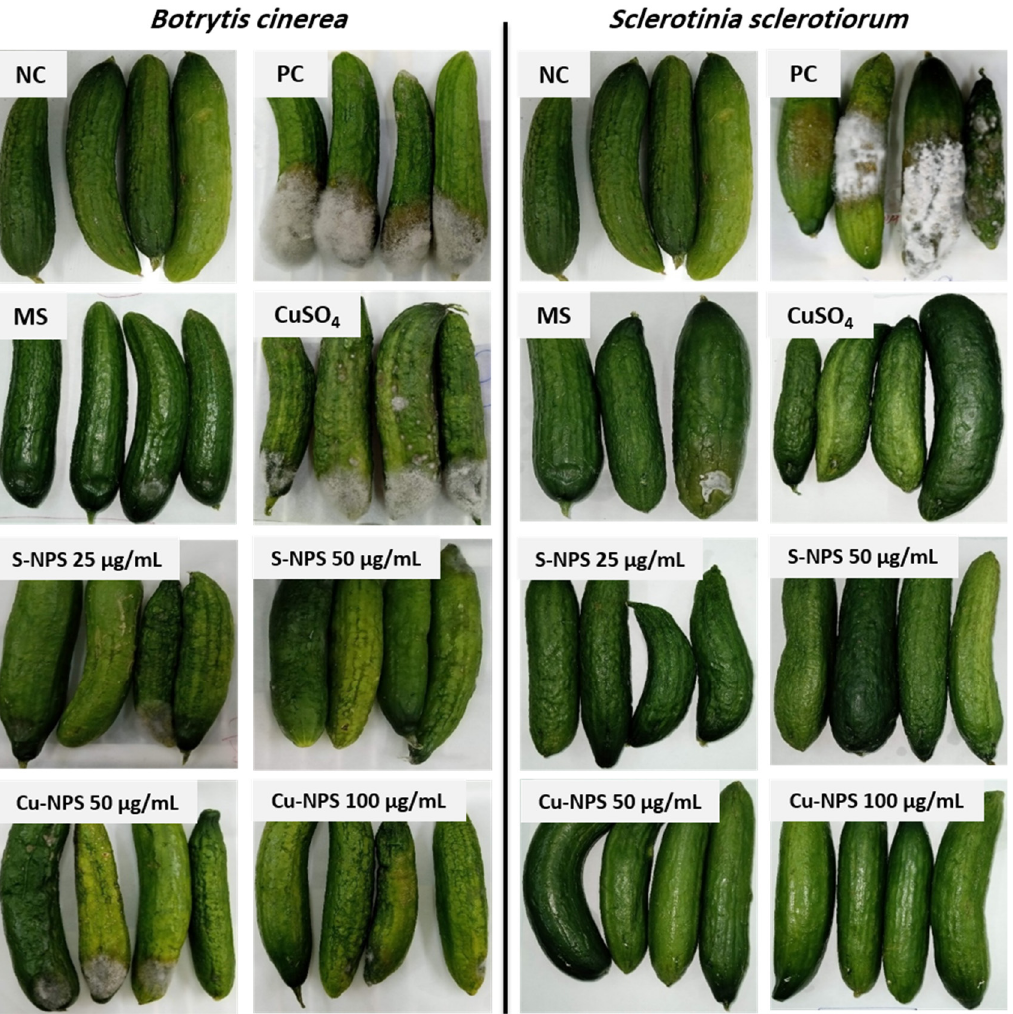
Figure 4. Effect of Cu-NPs and S-NPs at two concentrations (50 and 100 µg/mL) on disease incidence (DI) and disease severity (DS) caused by B. cinerea and S. sclerotiorum on cucumber fruits incubated at 20 °C in comparison with microsulfur (MS) (1000 µg/mL) and CuSO 4 (4000 µg/mL). NC = negative control (cucumber fruits were dipped into sterile distilled water for 10 min); PC = positive control (cucumber fruits were inoculated with pathogens but without antifungal treatments).